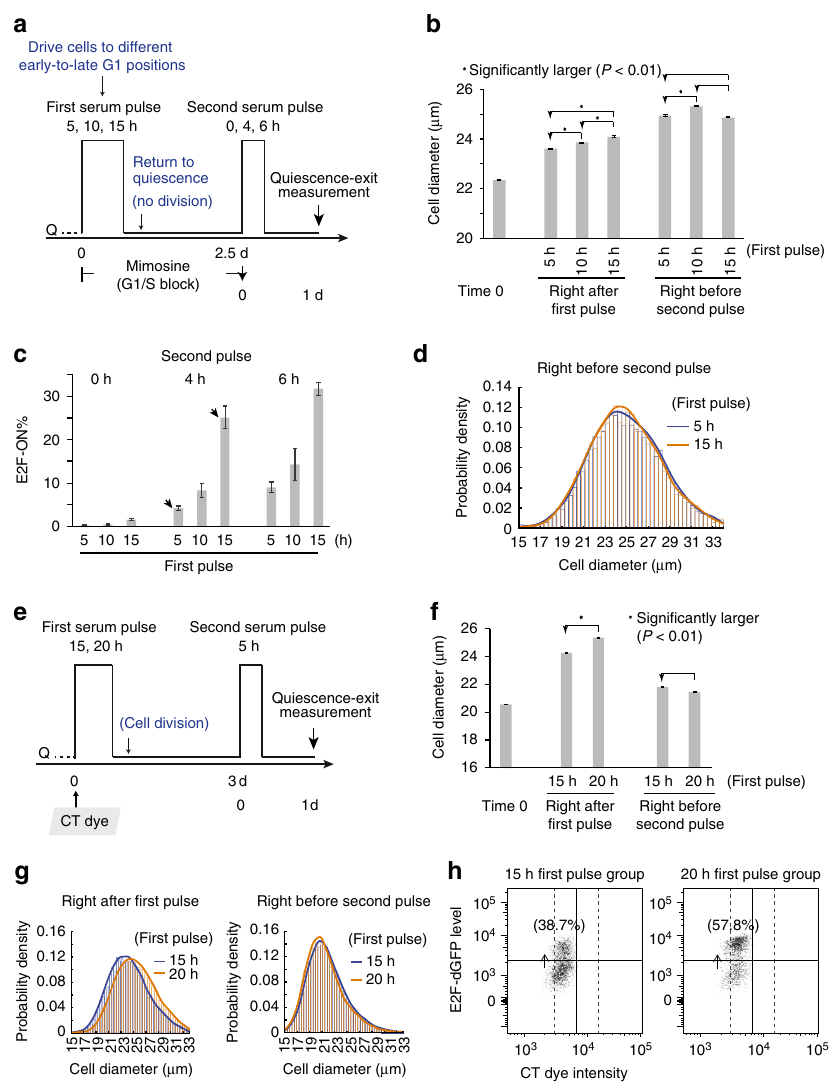
Fig. 2 Quiescence-exit likelihood is correlated with cell size at quiescence induction. a Experimental scheme. E2F-dGFP activity was measured one day after the initiation of the second serum pulse. See text for details. b Cell size measured right before the fi rst serum pulse (time 0), after the fi rst pulse (of 5 – 15 h), and before the second serum pulse, following the scheme in a . Star sign indicates statistical signi fi cance P < 0.01) in one-sided ( arrow pointed ) t -test comparing the means of cell diameters in two cell populations (20,000 – 30,000 cells each). Error bar, s.e.m. c Quiescence-exit rate (E2F-ON%, mean ± s.e.m. of duplicates) in response to the second serum pulse for indicated durations as a function of the fi rst serum pulse duration. d Probability density distribution of the cell size (diameter) of indicated cell samples in b right before the secnd serum pulse. The histogram curve represents a kernel smoothing fi t of cell size distribution (the same below). e Experimental scheme. Quiescent cells were stained with CT violet dye at time 0, and E2F-dGFP activity was measured one day after the second pulse initiation. See text for details. f Cell size measured right before the fi rst serum pulse (time 0), after the fi rst pulse, and before the second pulse, following the scheme in e . The star sign and error bar are as in b . g Probability density distributions of cell size (diameter), of indicated cell samples in f . h Scatter plots of fl ow cytometry results. Percentages of E2F-ON cells following the 2nd pulse are shown. Each dot represents one single cell. Cells to the left of solid vertical line corresponded to divided cells following the fi rst serum pulse (same gating as in Fig.